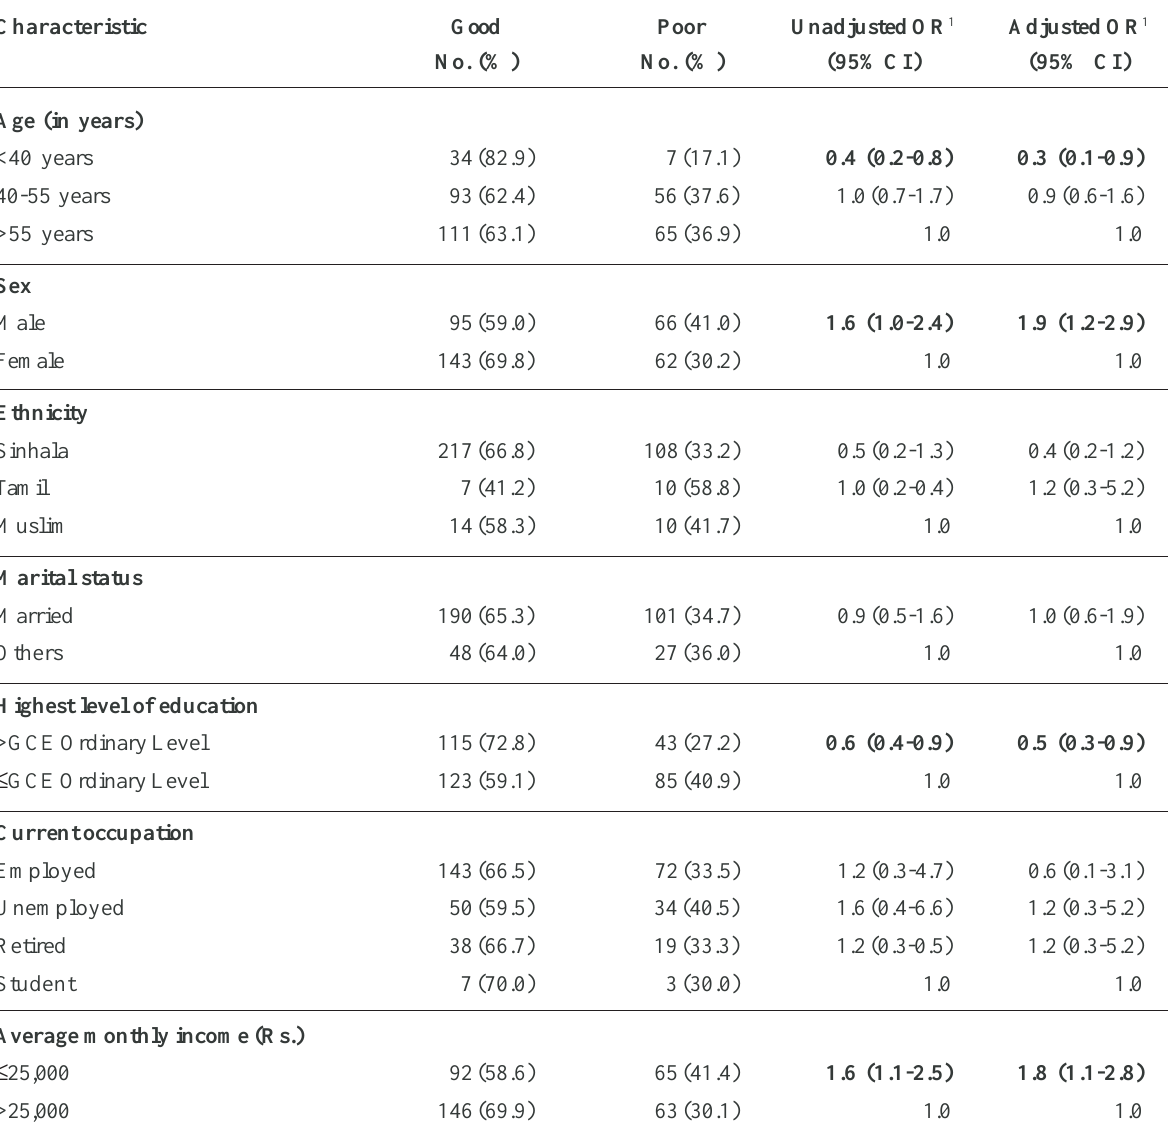
Table 2. Demographic and socioeconomic factors associated with treatment